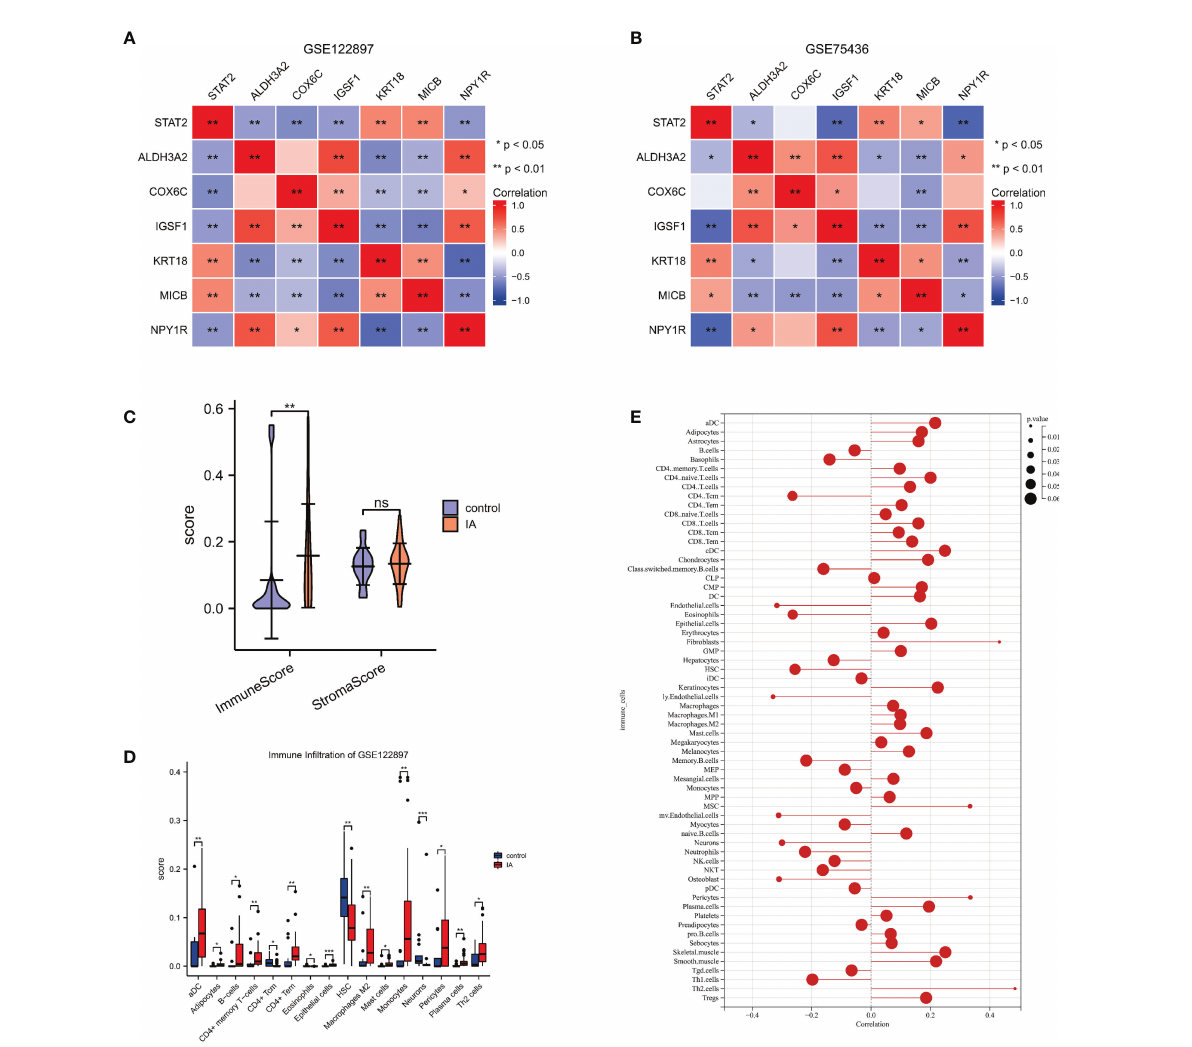
FIGURE 4 The correlations of STAT2 , the estrogen response pathway (ERP) and the immune in fi ltrating cells (A, B) The correlations of STAT2 and the characteristic genes of the ERP in GSE122897 and GSE75436. (C) The immune score and the stromal score of intracranial aneurysm (IA) samples compared with controls. (D) The in fi ltrating cells of IA samples compared with controls. (E) The correlation of STAT2 and the in fi ltrating cells. ns=no signi fi cance, * p <0.05, ** p <0.01, *** p